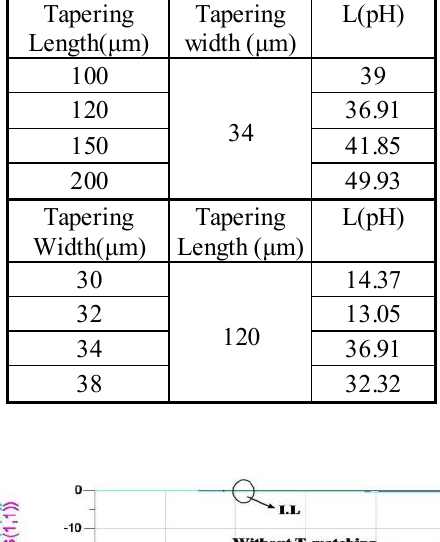
Table-IV: Parametric study of the T-match circuit Tapering